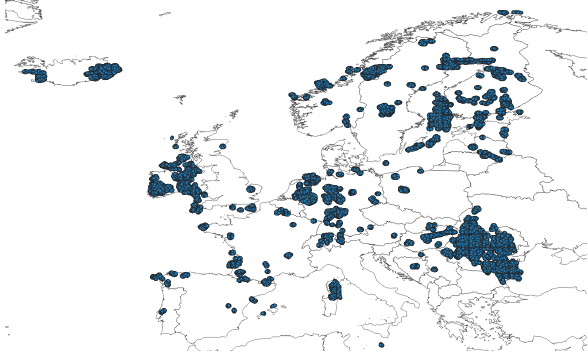
Figure 1. Example of rain data in QuadTile format for Europe.